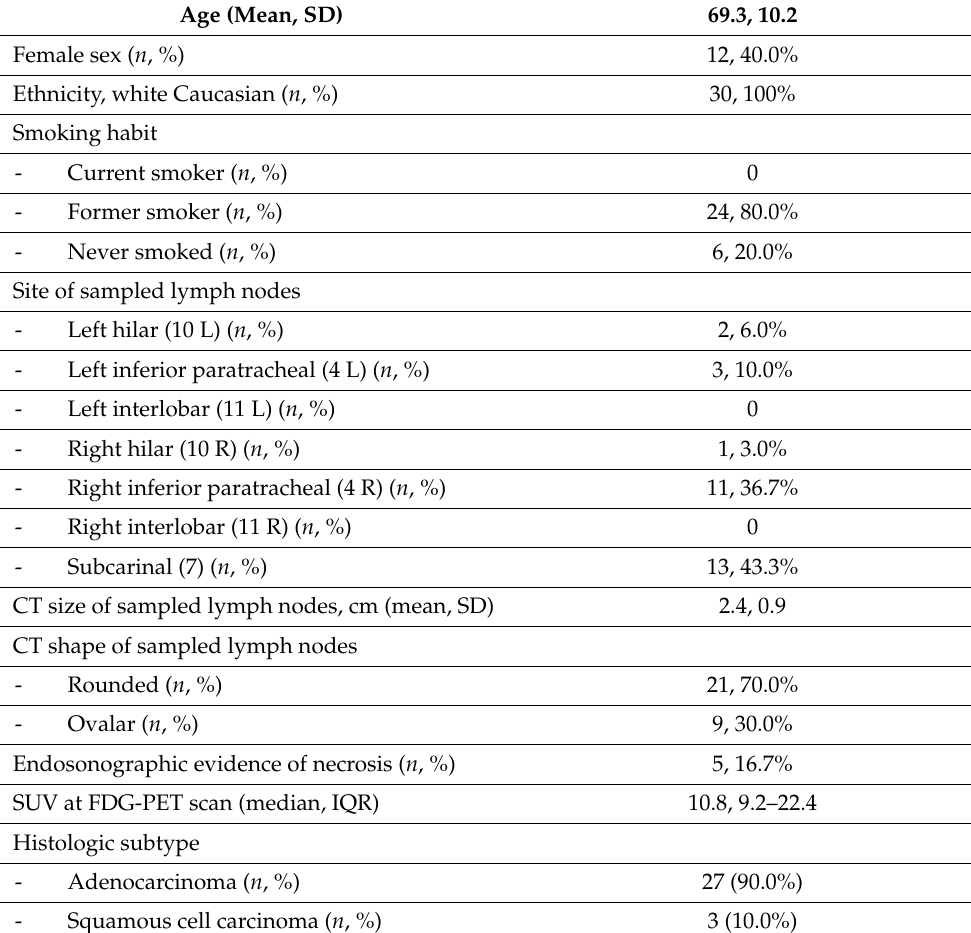
Table 1. Demographic, clinical, and imaging data of the study’s participants ( n = 30). Age (Mean, SD) 69.3,